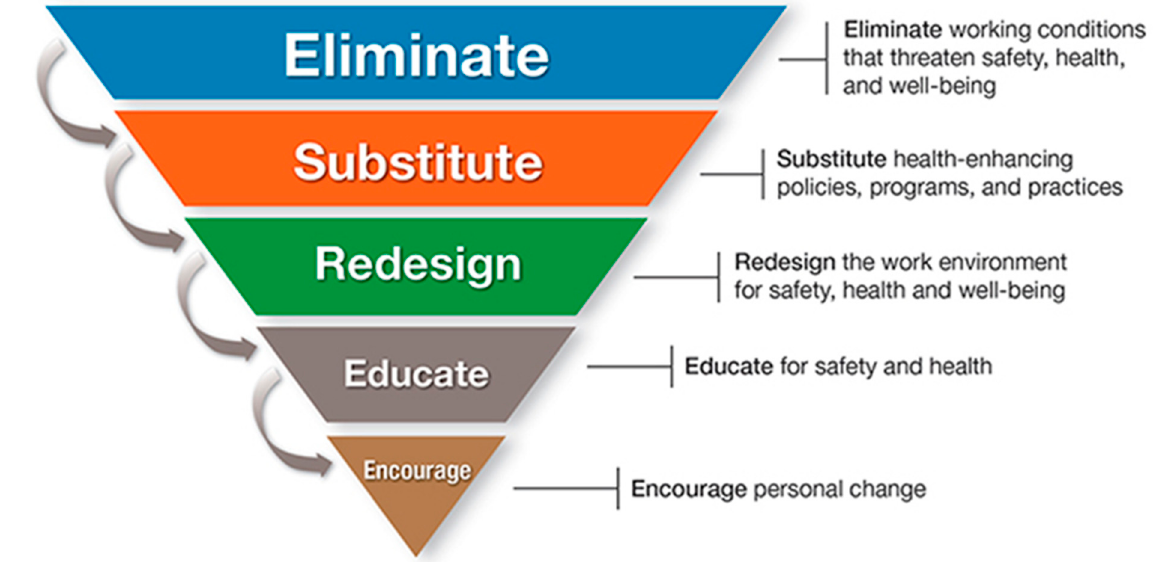
Figure 1. Hierarchy of Controls Applied to NIOSH Total Worker Health ® .